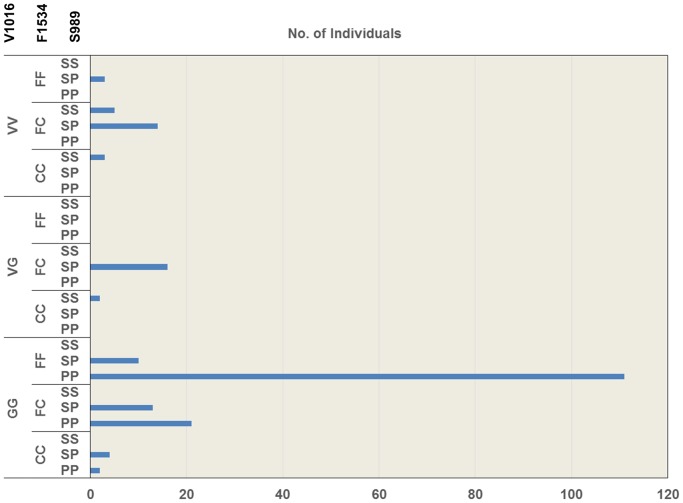
Genotyping of the V1016, F1534, and S989 point mutations in Aedes aegypti larvae.The larvae were collected from used tires in Yangon City. The total number of larval samples used for the analysis was 204.